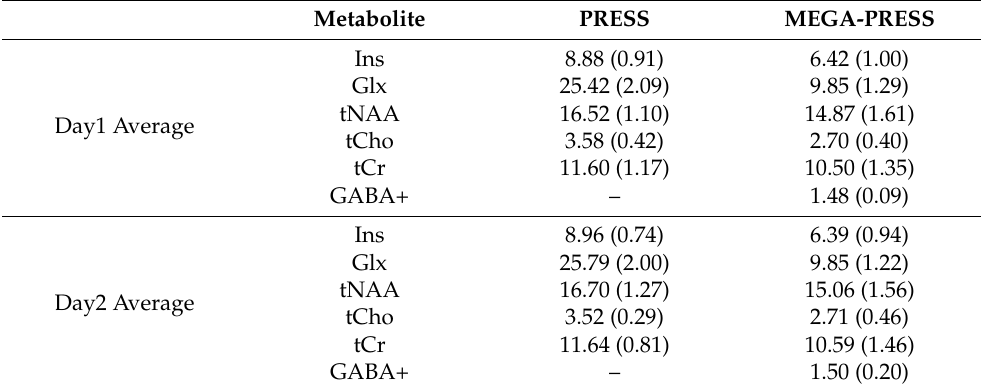
Table 4. Means (standard deviations) of metabolite concentration (IU) in the insula with PRESS and MEGA-PRESS, averaged across B2B values for each scan day.